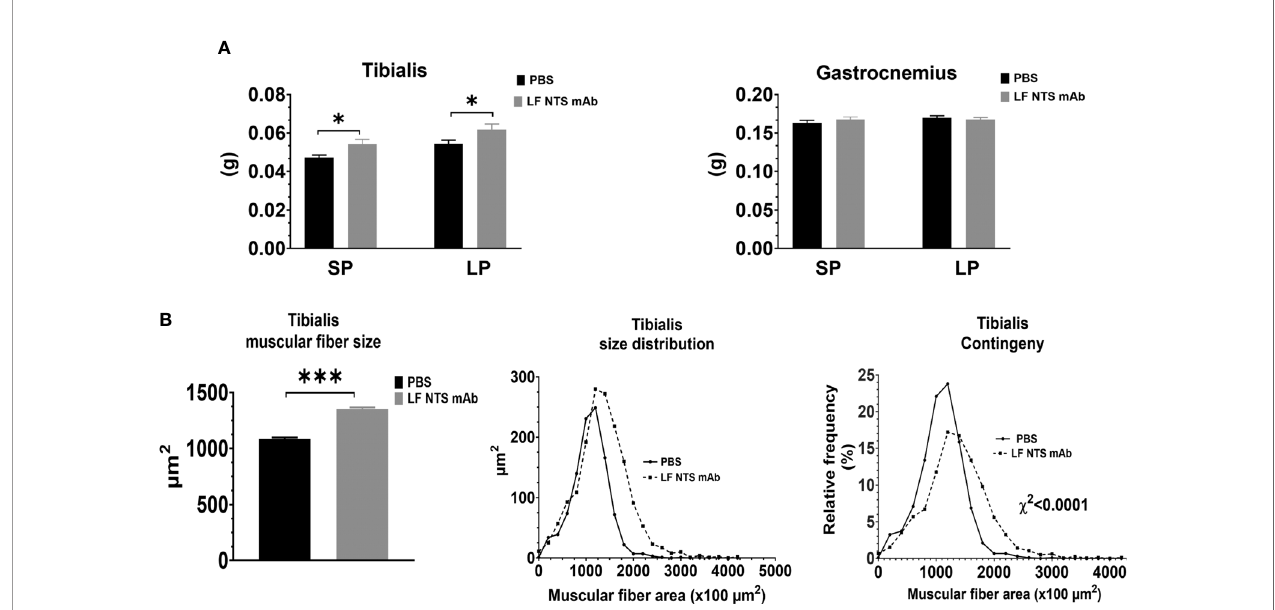
FIGURE 5 | Muscle analysis. Muscles were collected and weight immediately at the dissection. (A) Weight of tibialis and gastrocnemius from 9 animals at SP and 16 at LP. (B) Size and size distribution of the tibialis muscular fi bers at SP (n=8) t test *p < 0.05; ***p <